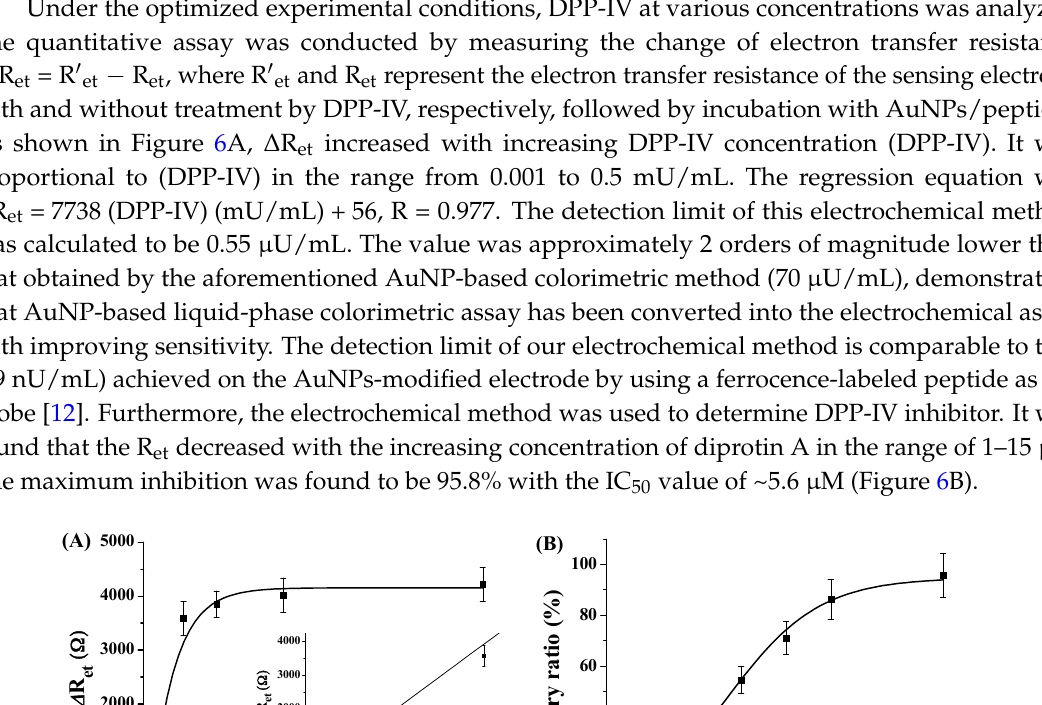
Figure 6. ( A ) Dependence of Δ R et on DPP-IV concentration (0, 0.001, 0.01, 0.05, 0.2, 0.5, 1, 2 and 5 mU/mL); ( B ) Inhibitory ratio of different concentrations of diprotin A (1, 2, 4, 6, 8, 10 and 15 μ M) on the DPP-IV (0.5 mU/mL) activity.